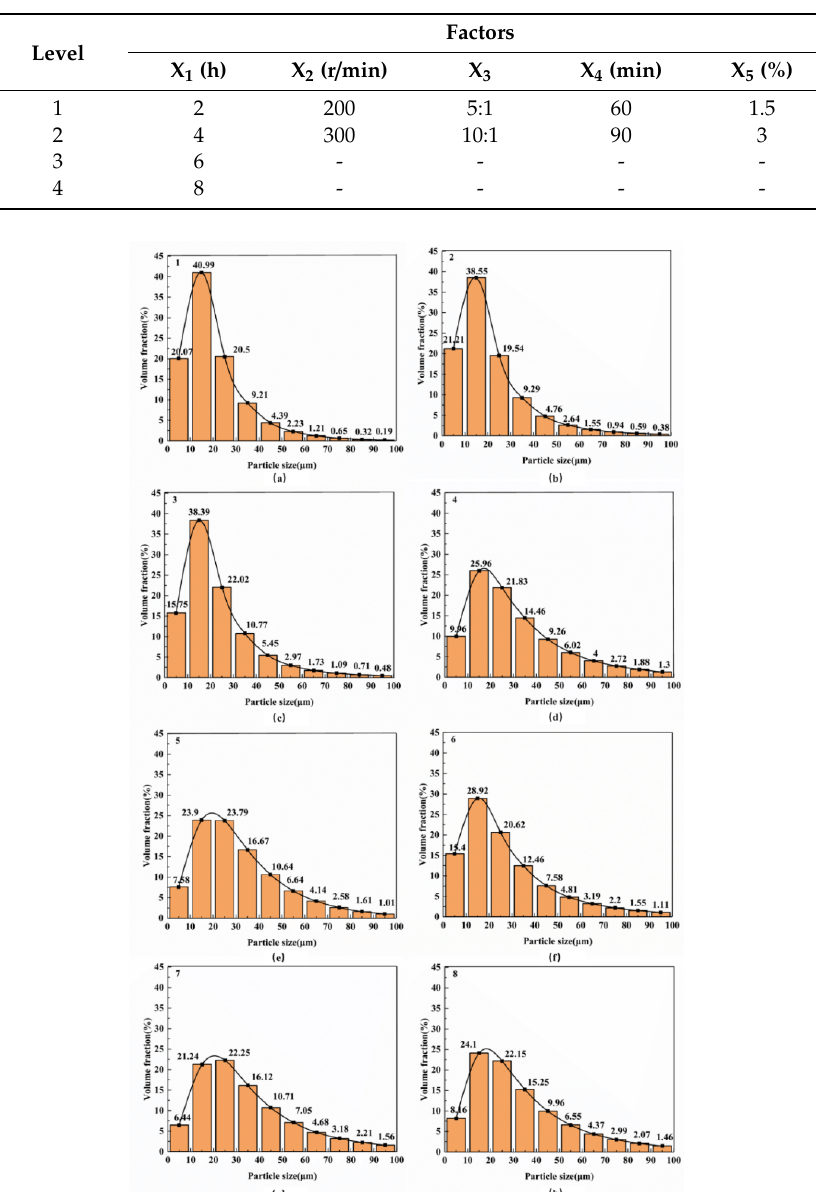
Figure 2. Particle size of 0.5 wt.% GNP/Al powder with different parameters. ( a ), ( c ), ( e ), ( g ): 200r/min, ball milling time of 2, 4, 6, 8 h; ( b ), ( d ), ( f ), ( h ): 300r/min, ball milling time of 2, 4, 6, 8 h.